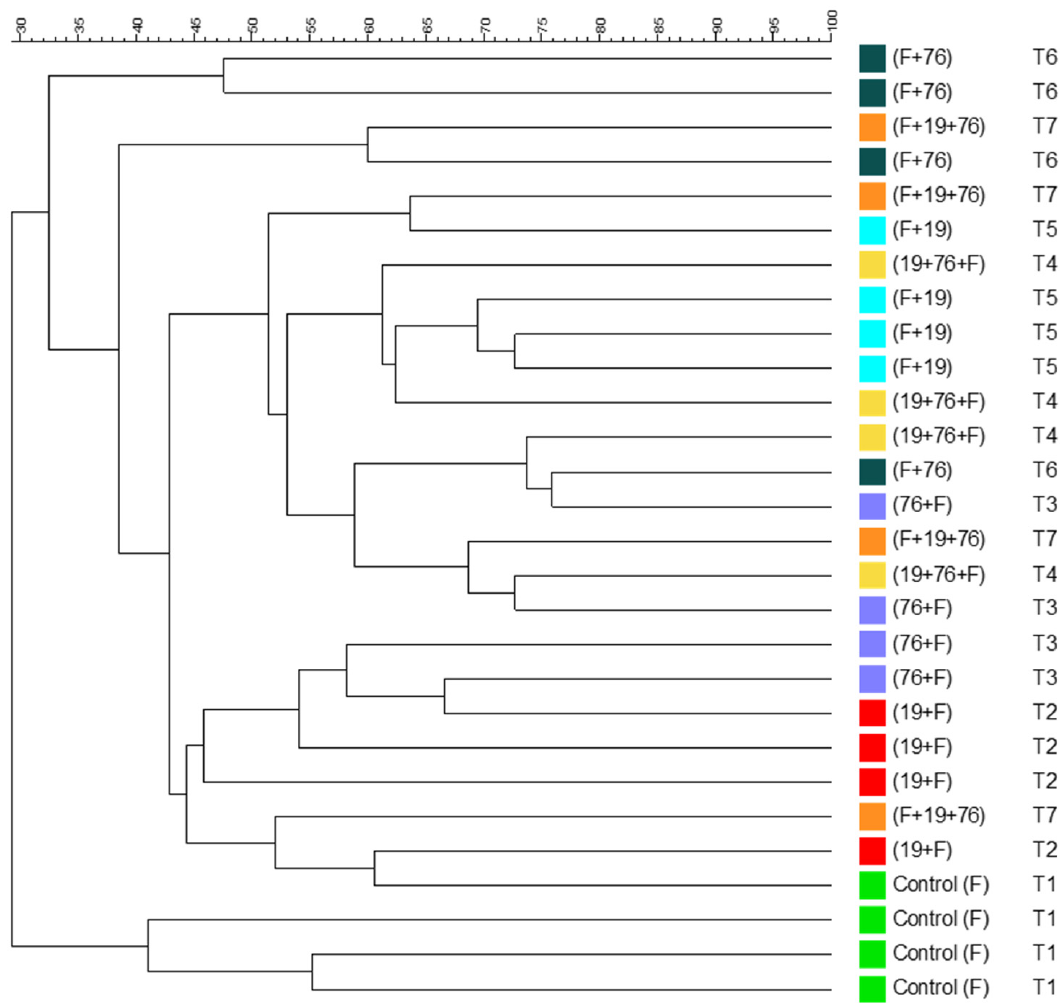
Figure 3. Dendrogram generated from the denaturing gradient gel electrophoresis (DGGE) using the unweighted pair group method with arithmetic mean (UPGMA) method and the Dice coefficient based on ITS fragments of the fungal community of the rhizosphere of treatments T1 to T7. F: inoculated with P. destruens ; 19: B. velezensis T149-19; 76: B. safensis T052-76.